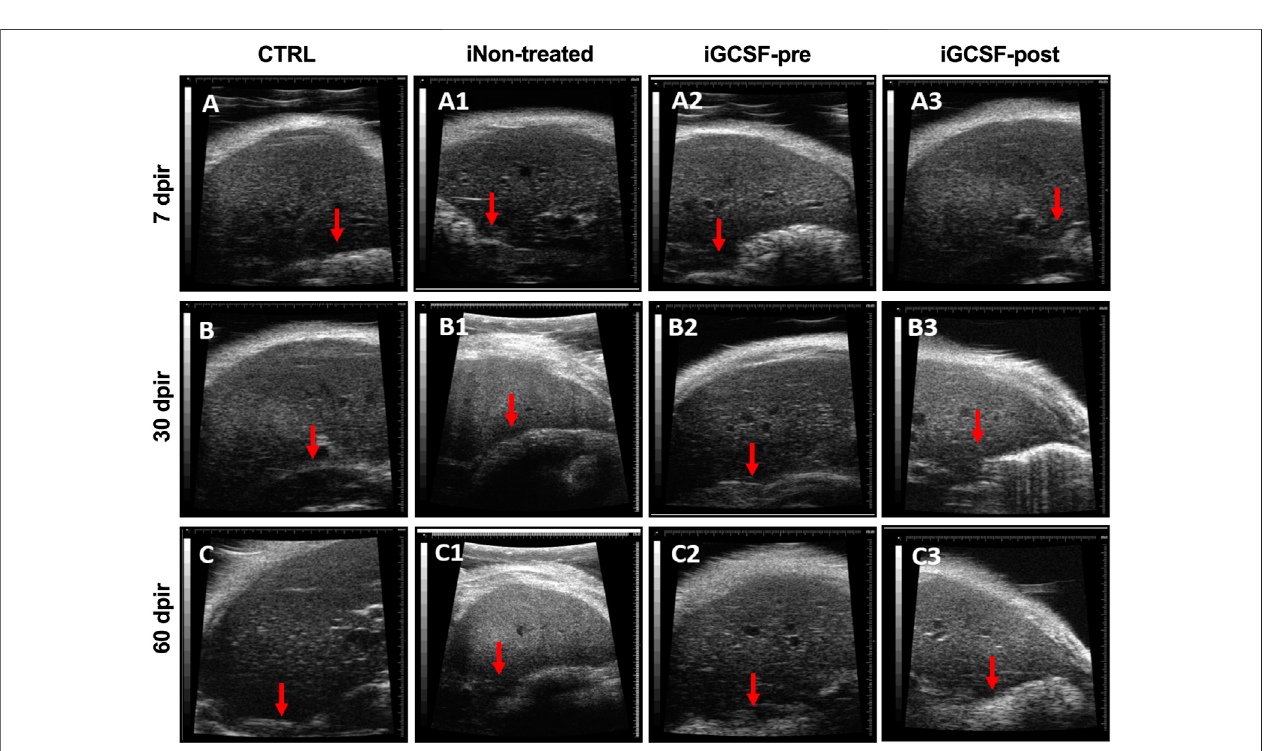
FIGURE2| Liverultrasound fi ndings.UltrasoundimagesobtainedfromCTRL (A – C) ,iNon-treated (A1 – C1) ,iGCSF-pre (A2 – C2) and,iGCSF-post group (A3 – C3) at 7, 30- and 60-days post-irradiation. Images obtained from a healthy animal show normal liver echogenicity and a homogeneous, smooth and, regular surface (indicated by red arrow) (A – C) . iNon-treated group images (A1 – C1) showed liver parenchyma with fi nely and slightly heterogeneous and increased echogenicity. Besides, a lobulated liver surface was too observed (indicated by red arrow). Similarities were observed in animals of the iGCSF-pre Group in 30 (B2) and 60 dpir (C2) and all animals in the iGCSF-post Group (A3 – C3) . Images obtained from iGCSF-pre in 7 dpir (A2) revealed similarities with CTRL group, maintaining its homogeneous echogenicity and regular surface ( n (cid:1) 8 per